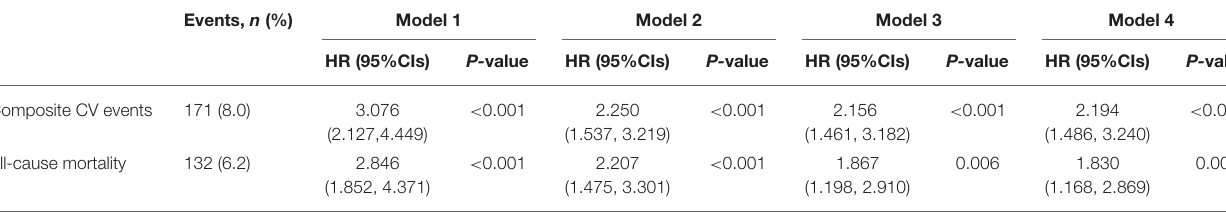
TABLE 2 | Cox regression analysis of left ventricular diastolic dysfunction (LVDD; E / e ′ > 14) for clinical outcomes. Events, n (%)